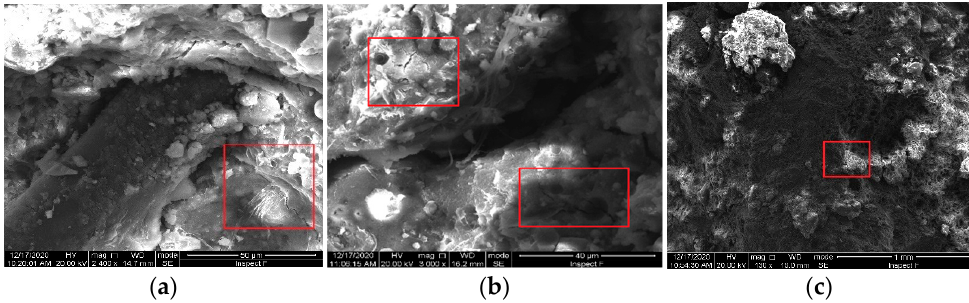
Figure 8. Micro-structure of GPCC: ( a ) fiber/matrix interface; ( b ) cement matrix near GHB; ( c ) GHB/matrix interface.